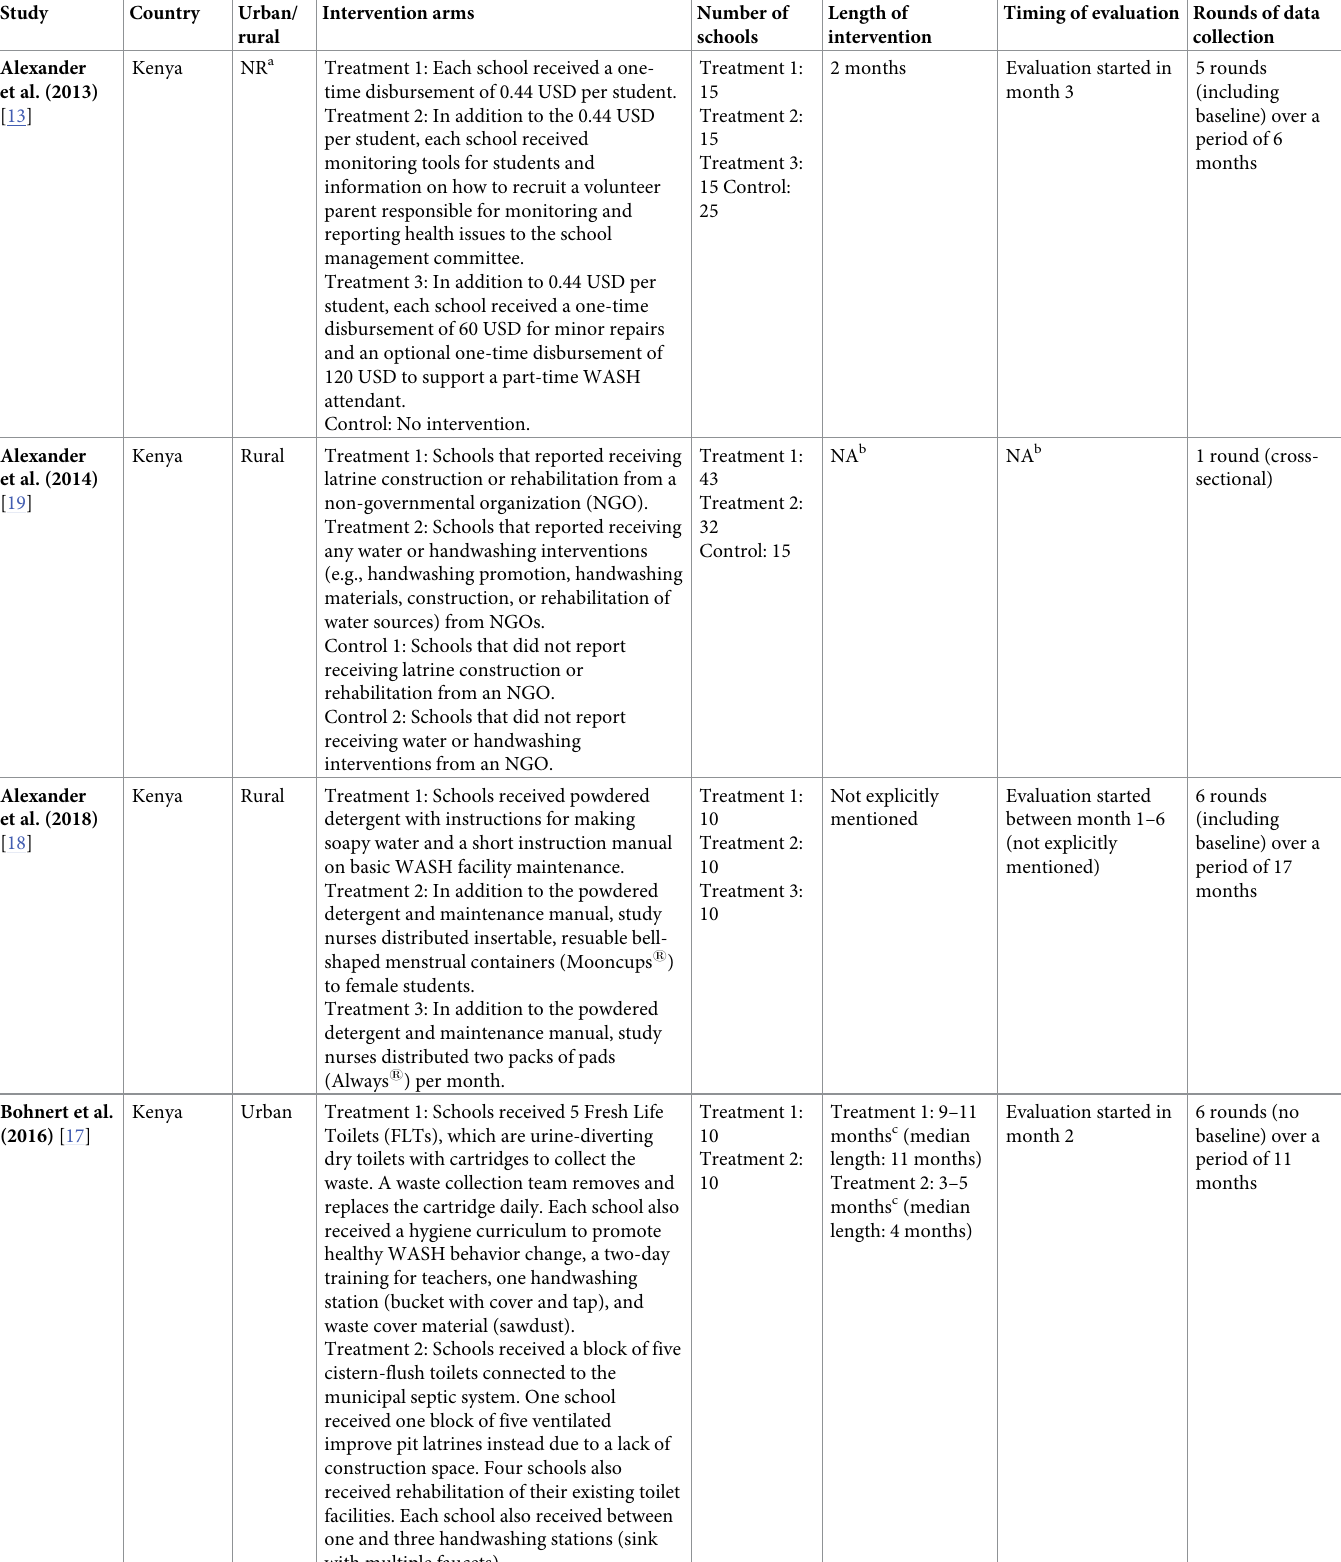
Table 2. Summary characteristics of experimental and quasi-experimental studies that evaluated WASH infrastructure maintenance and consumables provision interventions in schools.